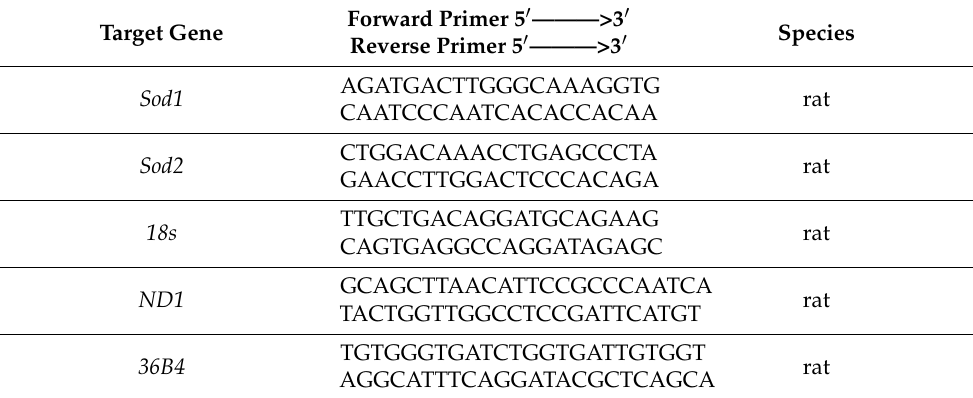
Table 2. Primer sequences used for quantitative real-time PCR amplification. Target